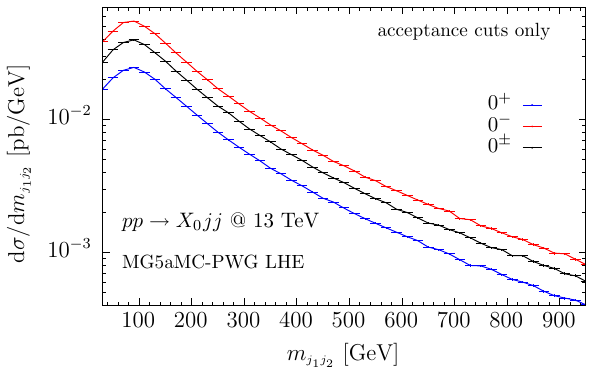
Fig. 1 Differential cross section as a function of the invariant-mass distribution of the two leading jets in pp → X 0 jj for the three CP scenarios. The blue curve corresponds to the CP-even scenario with cos α = 1, the red curve to the CP-odd scenario with cos α = 0 and the black curve to the mixture of the 0 + and 0 − scenarios with cos α = √ 1 /